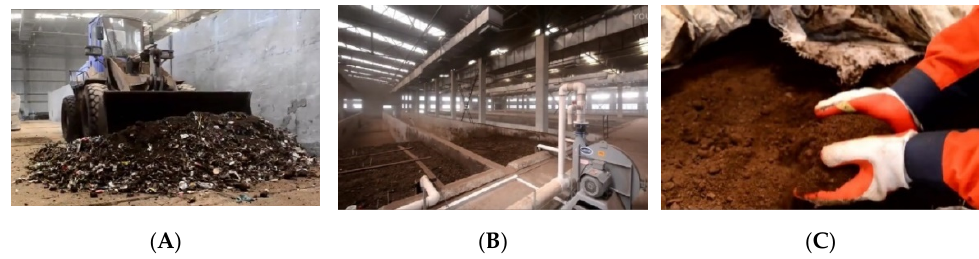
Figure 4. Photograph of the full-scale hyperthermophilic composting process. ( A ) Mixture of inoculants and organic solid waste; ( B ) composting; ( C ) mature compost [67].